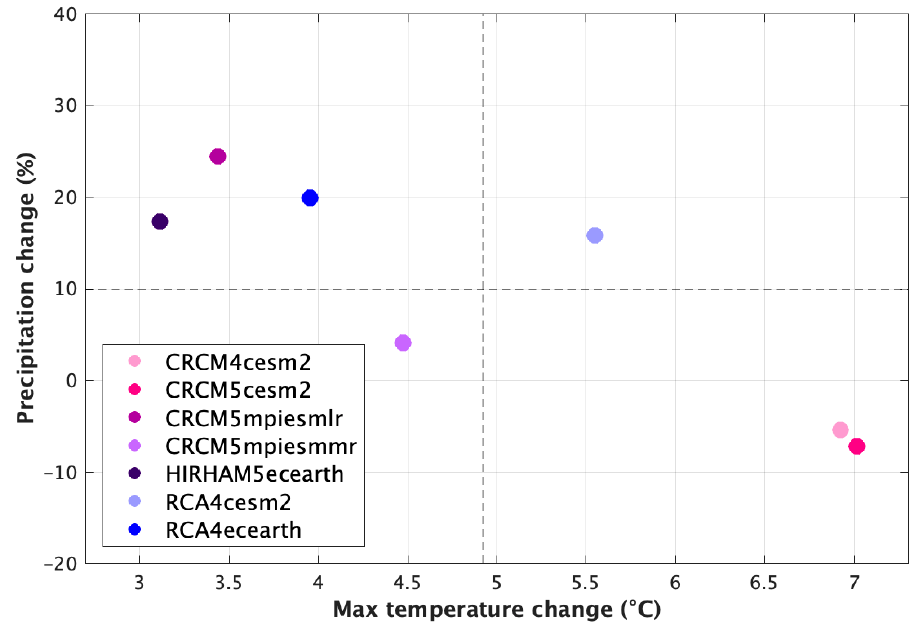
Figure 19. Projected changes from trends in growing season (May–August) maximum temperature and total precipitation (each colored circle represents a different RCM, and the dashed lines represent average climatic changes).